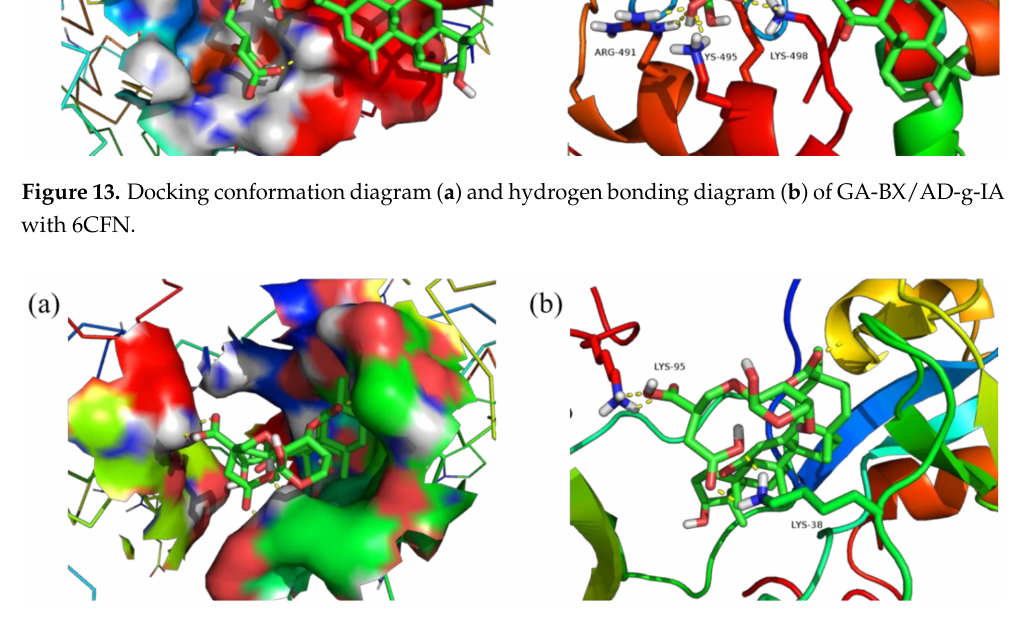
Figure 14. Docking conformation diagram ( a ) and hydrogen bonding diagram ( b ) of GA-BX/AD-g-IA with